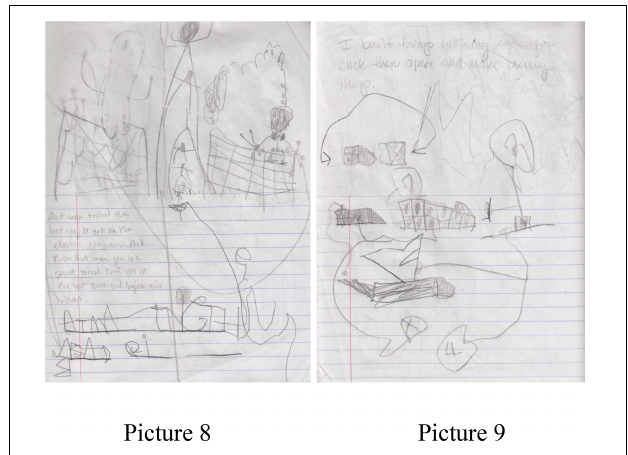
FIGURE 3 | Pictures 8 and 9 detailing a story from Orlando, a 6-year-old student.